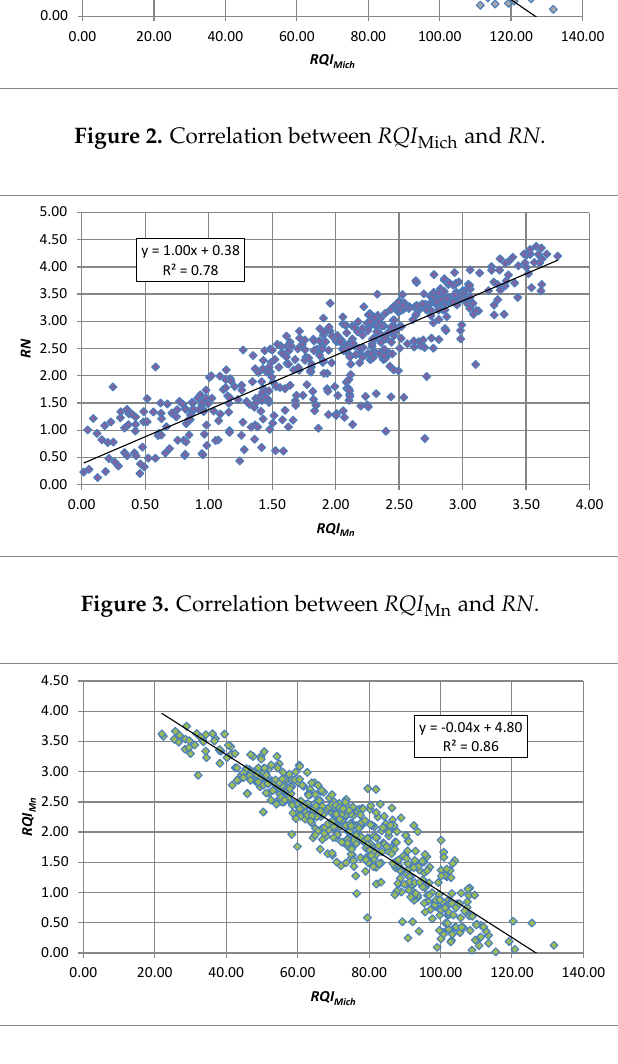
Figure 4. Correlation between RQI Mich and RQI Mn .